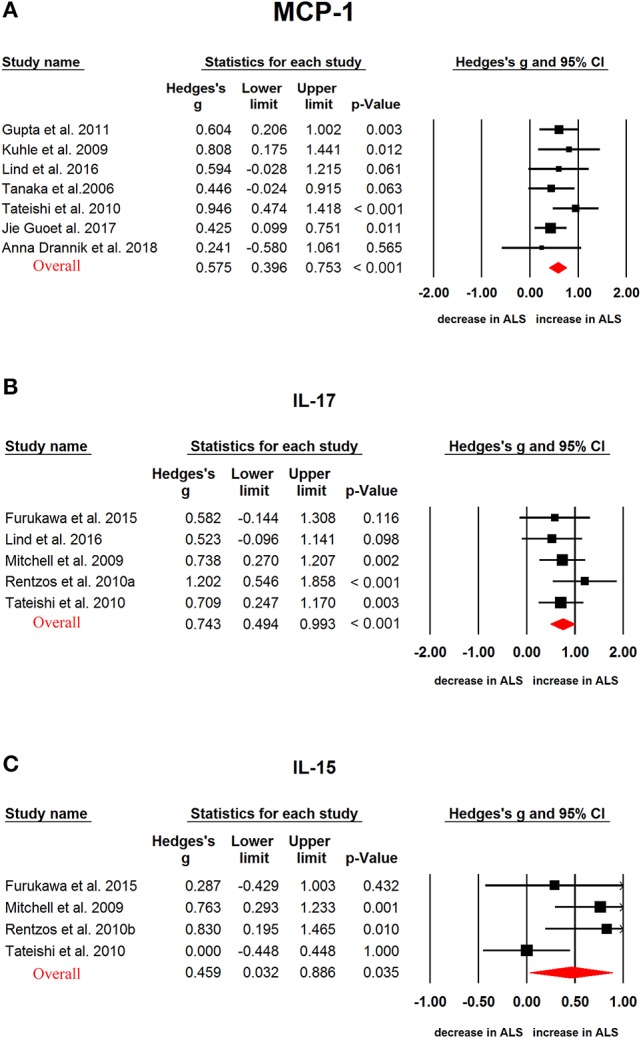
Studies of cerebrospinal fluid MCP-1, IL-17, and IL-15 in Amyotrophic lateral sclerosis. Forest plot displaying random-effects meta-analysis results of the association between MCP-1 (A), IL-17 (B), IL-15 (C) and Amyotrophic lateral sclerosis. The sizes of the squares are proportional to study weights.